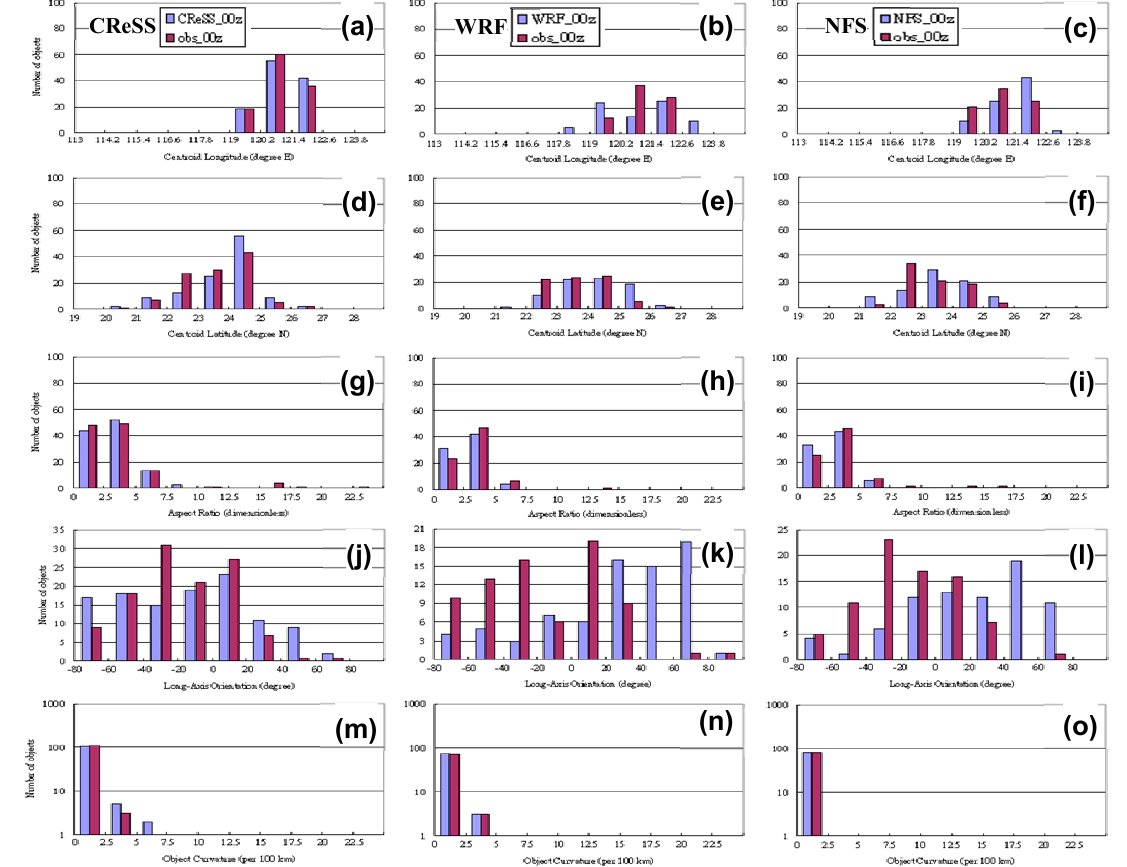
Figure 5. As in Figure 4 but for (a-c) centroid longitude (°E), (d-f) centroid latitude (°N), (g-i) aspect ratio (dimensionless), (j-l) long-axis orientation (degree), and (m-o) object curvature (radius per 100 km), respectively. In panels (m - o) , the logarithmic scale is used in the vertical axis. Note that in panels (j - l) , the scales in vertical axis are different.